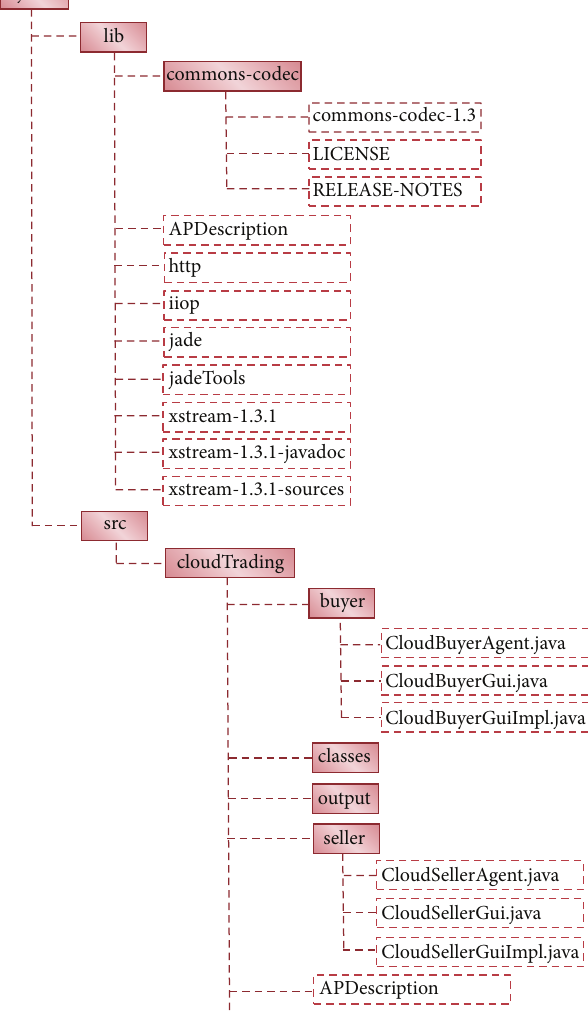
Figure 7: Source code package